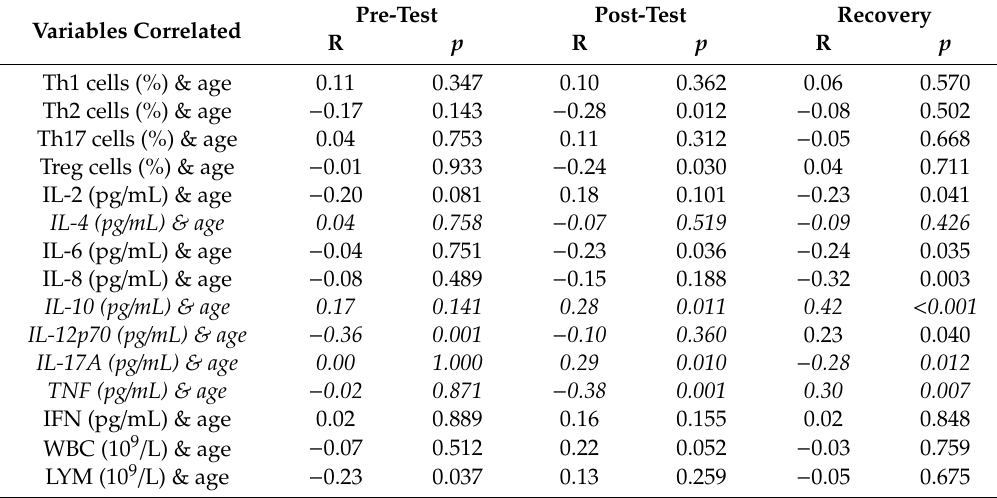
Table 5. Coe ffi cients of correlation between analyzed variables and the age of the participants. Variables